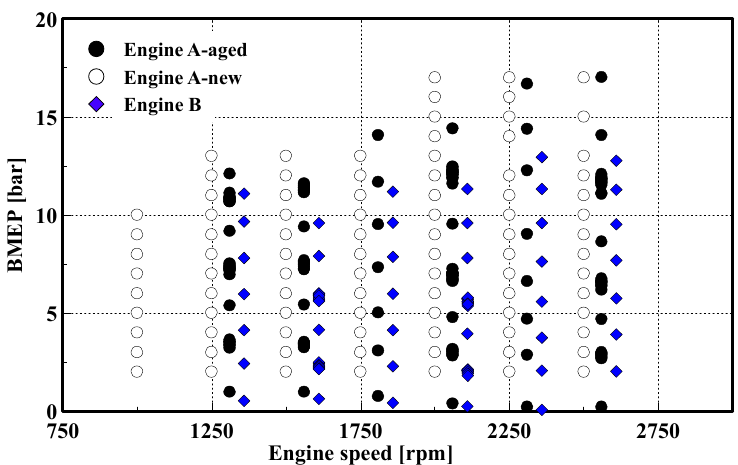
Figure 2. Experimental conditions for steady-state evaluation. Clusters of marks are shown when operating parameters were swept. The engine speed test conditions were equivalent to engine A-new ( n = 91), but engine A-aged ( n = 220) and engine B ( n = 99) are shifted aside for visibility.